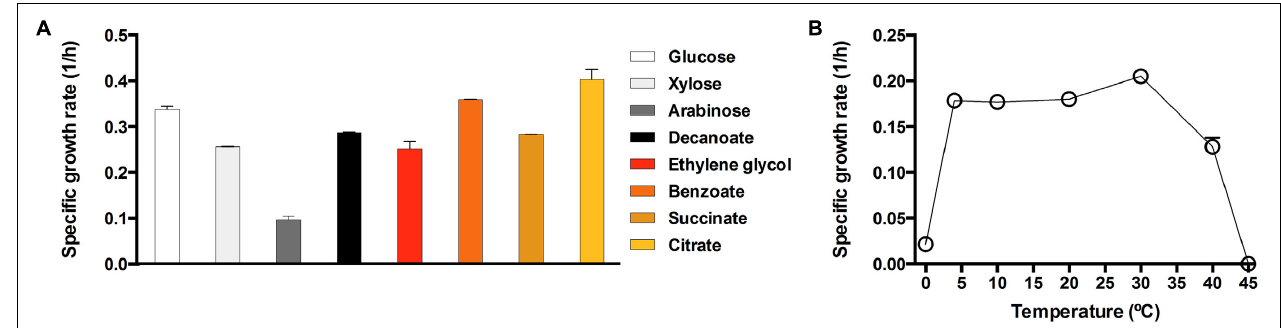
FIGURE 4 | Specific growth rates of the strain Pseudomonas sp. MPC6. Specific growth rate (1/h) of the psychrotolerant bacterium in presence of various carbon sources (A) , or at different temperatures on glycerol (B) . Each experiment was conducted at least in triplicates. Error bars represent the standard